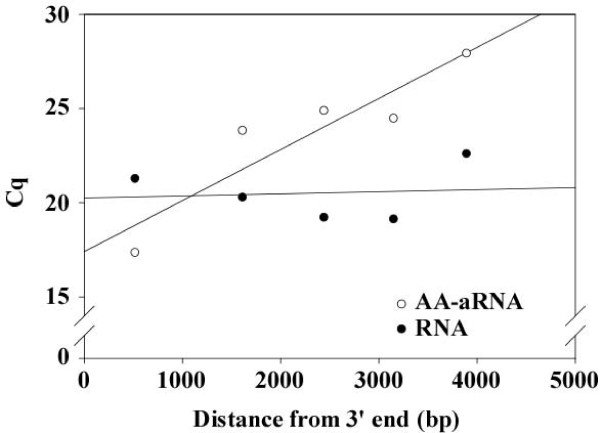
Choice of primer location for qPCR from AA-aRNA. One μg of universal reference RNA and 100 ng AA-aRNA were reverse transcribed using our optimized RT protocol. Resulting cDNAs were diluted 10-fold and subjected to qPCR using 5 pairs of primers located at different distances of the 3' end of the hif1a gene. Cq values were plotted against these distances. Linear regression lines illustrate the effect of increasing the distance from 3' end. Moving away primers from the 3' end increased Cq values when performing qPCR with cDNA generated from AA-aRNA.